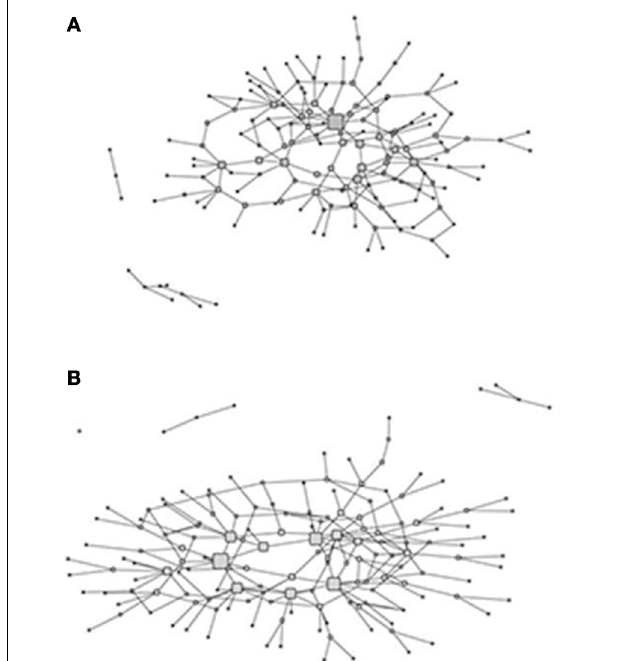
FIGURE 2 | Graphs of the fish (A) and hunt (B) knowledge networks with the size of the nodes (corresponding to hunters and fishers) proportional to normalized betweenness centrality.